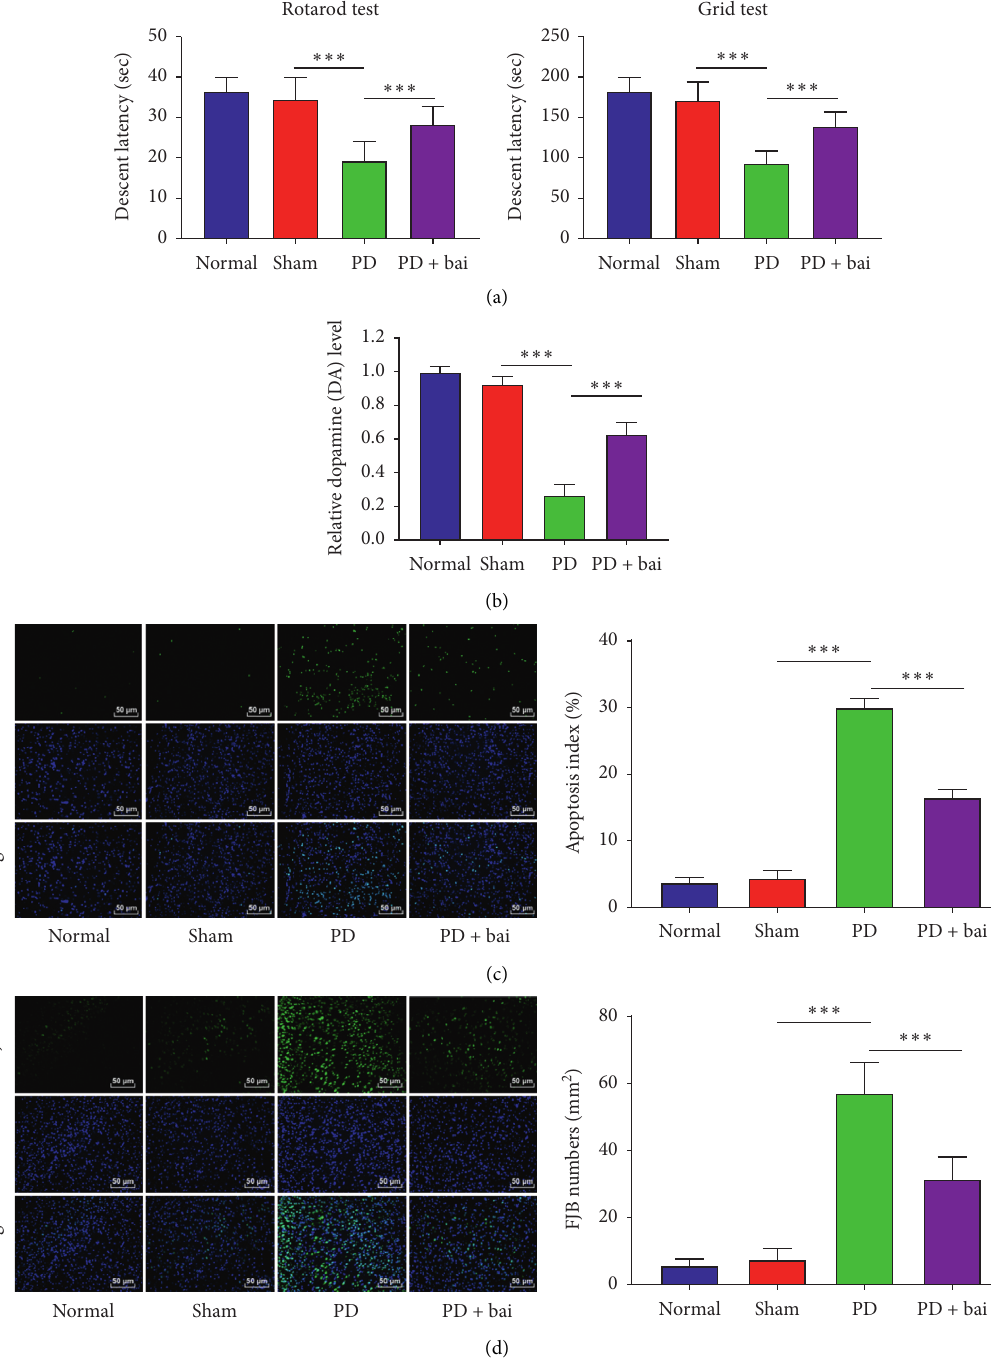
Figure 1: Baicalein played a protective role in PD rat model. PD model operation was performed in SD rats, and the protective effect of baicalein on PD rats was observed after baicalein treatment. (a) Neurological score; (b) DA content was detected by HPLC-EC; (c) apoptosis was detected by TUNEL staining; (d) neuronal degeneration was detected by Fluoro Jade B staining. N � 6. The data in the figure are all measurement data and the data are expressed as mean ± standard deviation; one-way ANOVA was used for variance analysis; Tukey’s multiple comparisons test was used for post hoc test. ∗∗∗ P < 0 .